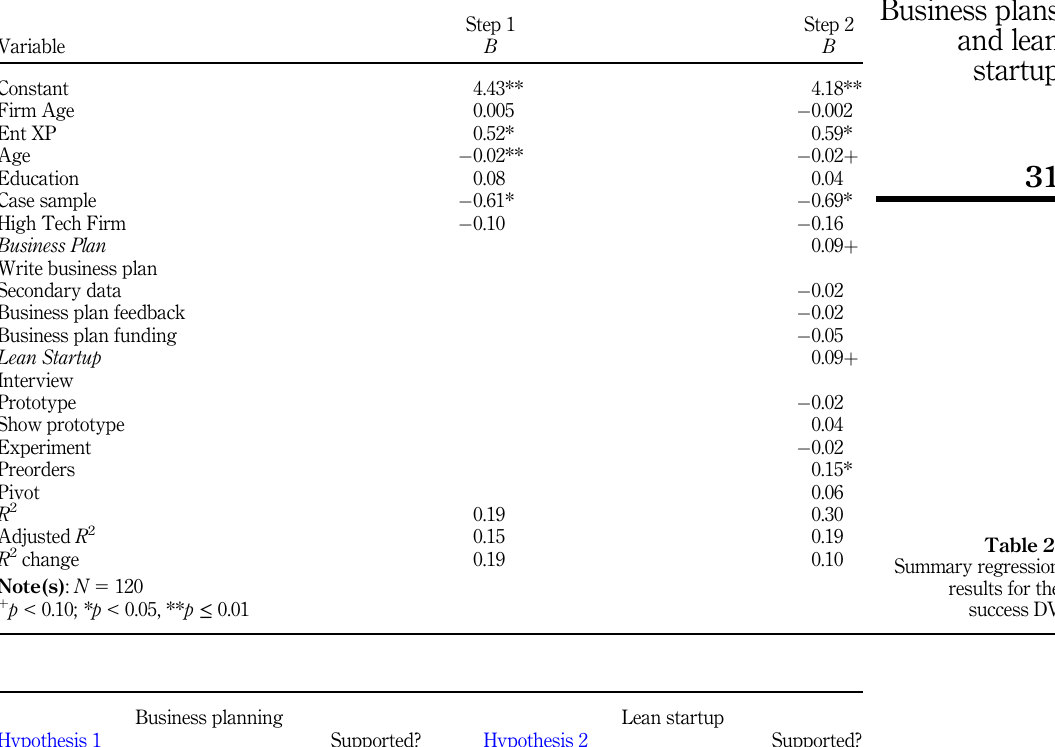
Table 3. Summary findings